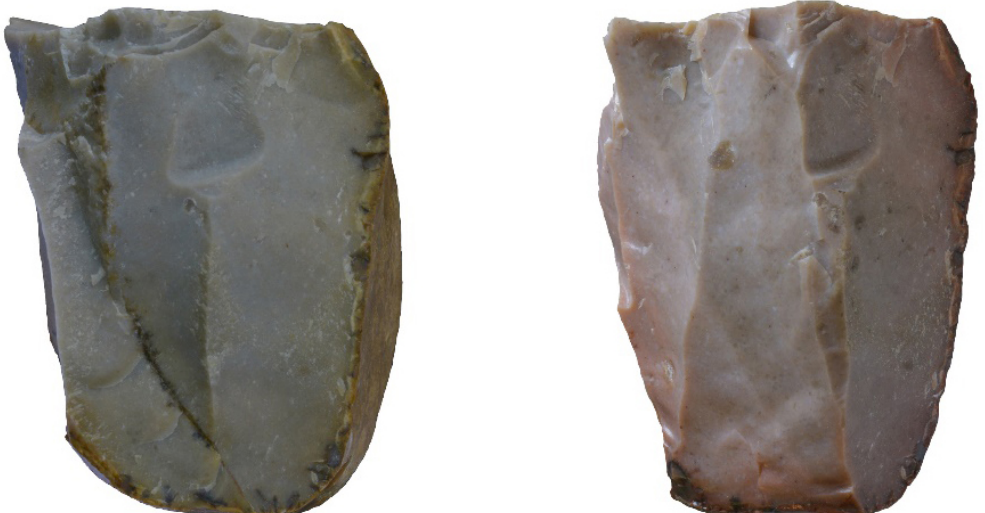
Figure 9. Flint core preform successfully heat treated by open fire. Left: Before heat treatment. Right: After heat treatment (a couple of blades were flaked after heat treatment, and the flaked scars show a greasy lustre).